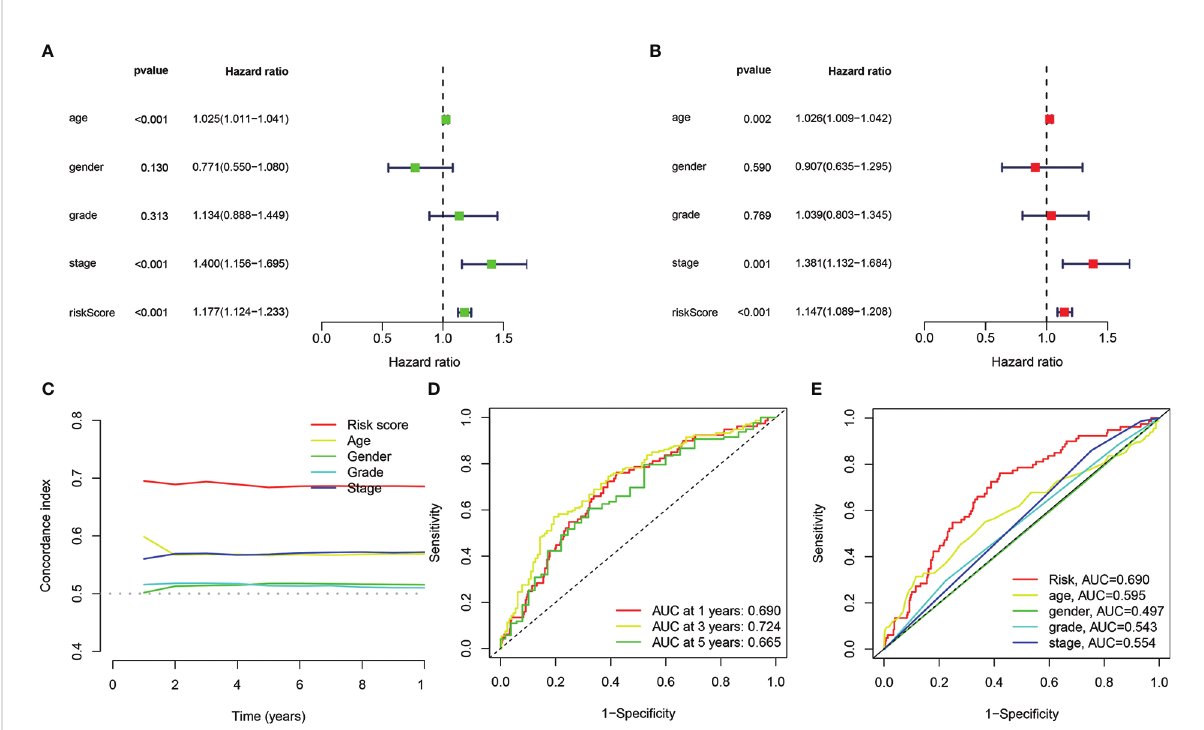
FIGURE 5 In TCGA cohorts, the cuproptosis-related lncRNAs prognostic risk model assessment and the HNSCC clinical features. (A, B) The clinical characteristics and risk score with the OS univariate and multivariate analyses. (C) Risk score and clinical properties of concordance indexes.